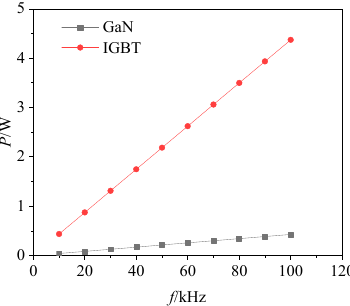
Figure 13. The relation between switching loss and frequency.